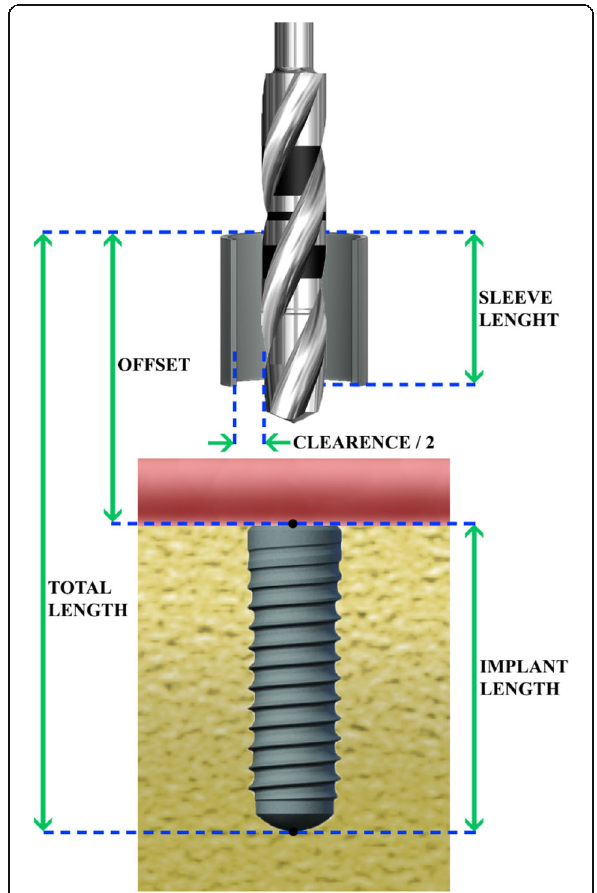
Fig. 1 The parameters used for the calculation of the various errors and the deviation of implant